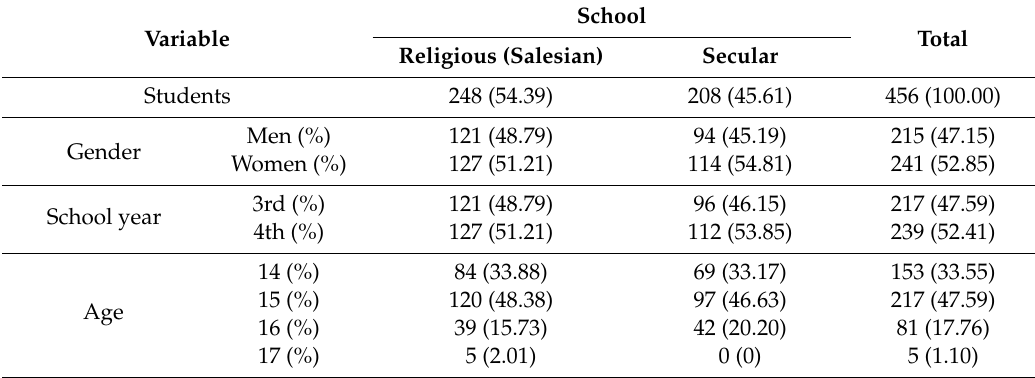
Table 1. Sample distribution by school and variables (gender, school year, and